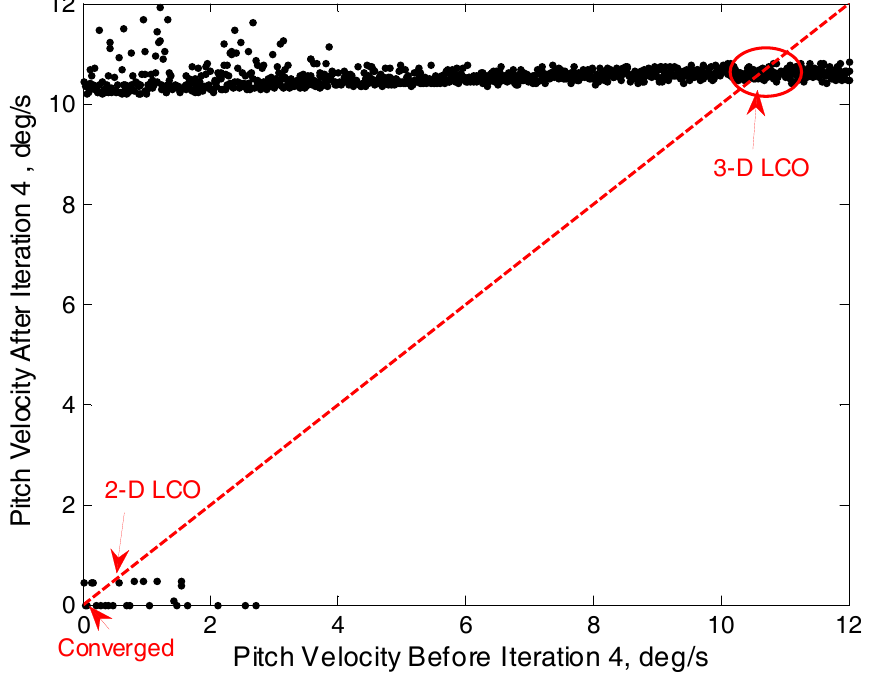
Figure 22. The iteration plot of the pitch velocity in Iteration-4, where two kinds of LCOs, as well as the convergence of the system response, are found. The airspeed is 20 m/s.